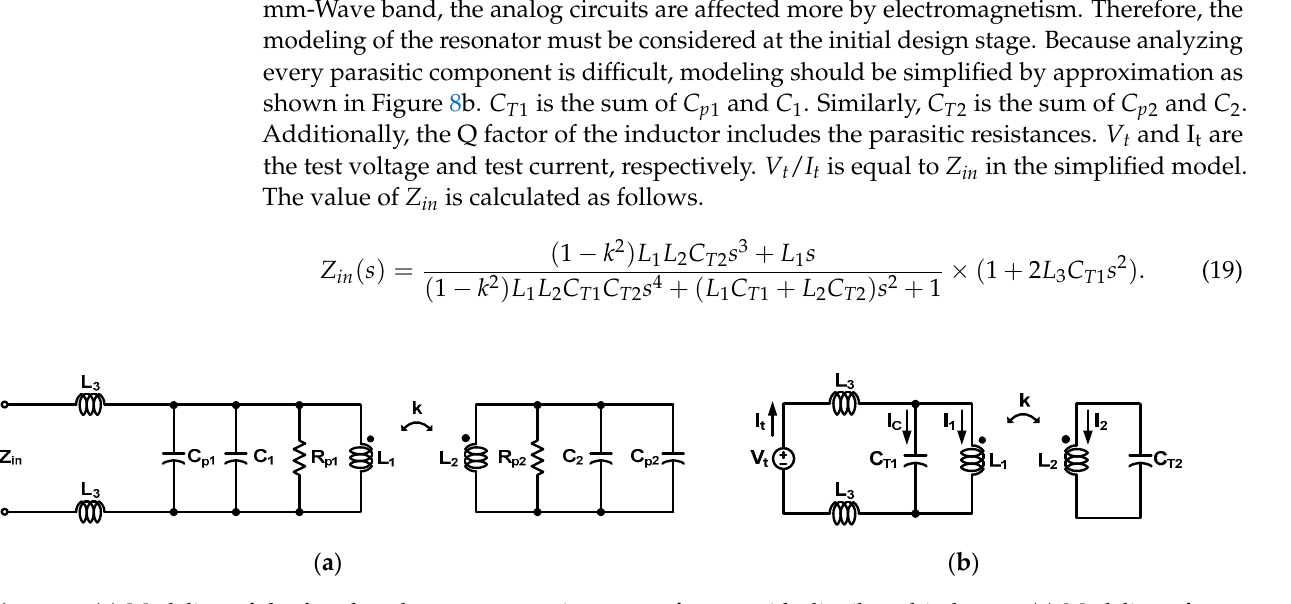
Figure 8. ( a ) Modeling of the fourth-order resonator using a transformer with distributed inductor. ( a ) Modeling of including the parasitic capacitors and resistors. ( b ) Approximate modeling applied to simplify calculations.